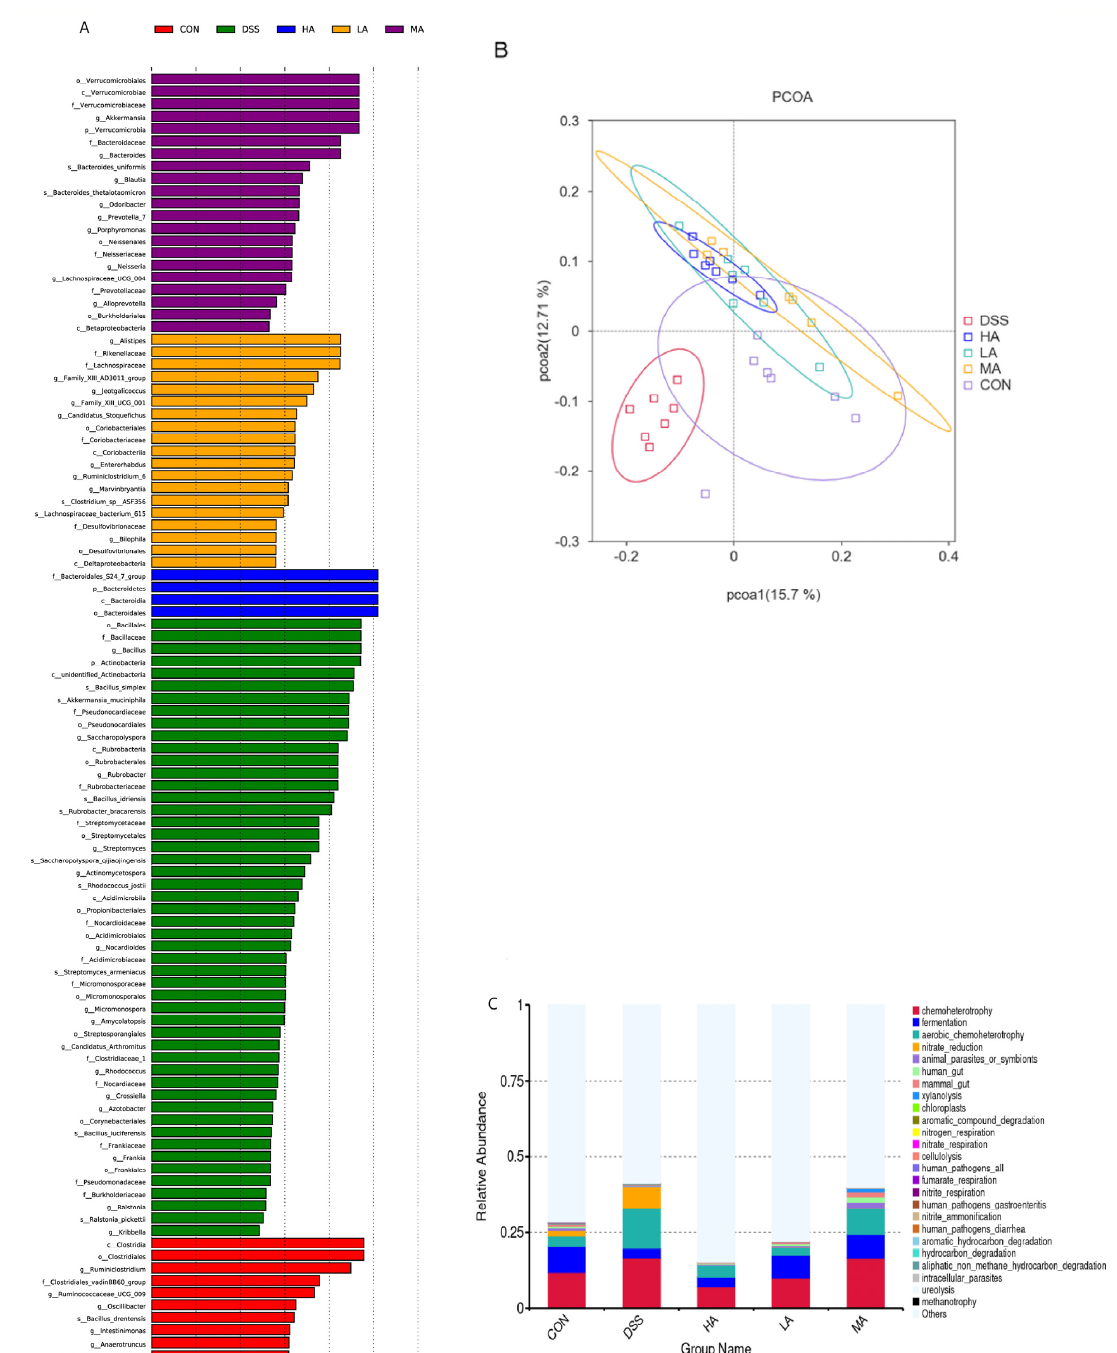
Figure 5. The PCOA figure and predictive functional profiling of colonic microbes. ( A ) Significant flora changes among the CON, DSS, LA, MA, HA groups, as measured by LEfSe analysis. ( B ) The PCOA figure of colonic microbes. ( C ) The predictive functional profiling of microbial communities. Values are expressed as the mean ± SEM, n =